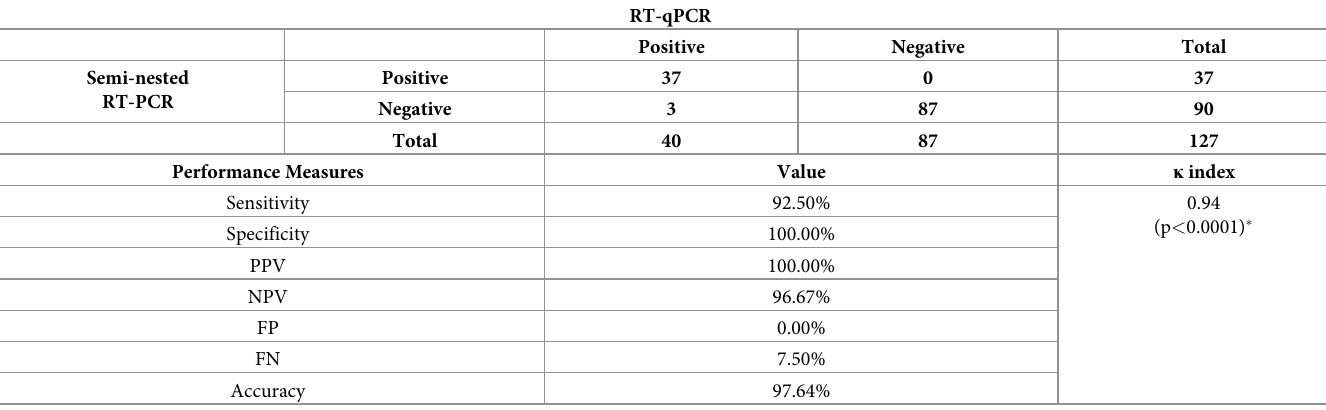
Table 7. Contingency table showing the results obtained by Semi-nested RT-PCR compared with those obtained by RT-qPCR as reference assay. RT-qPCR Positive Negative Total Semi-nested Positive RT-PCR